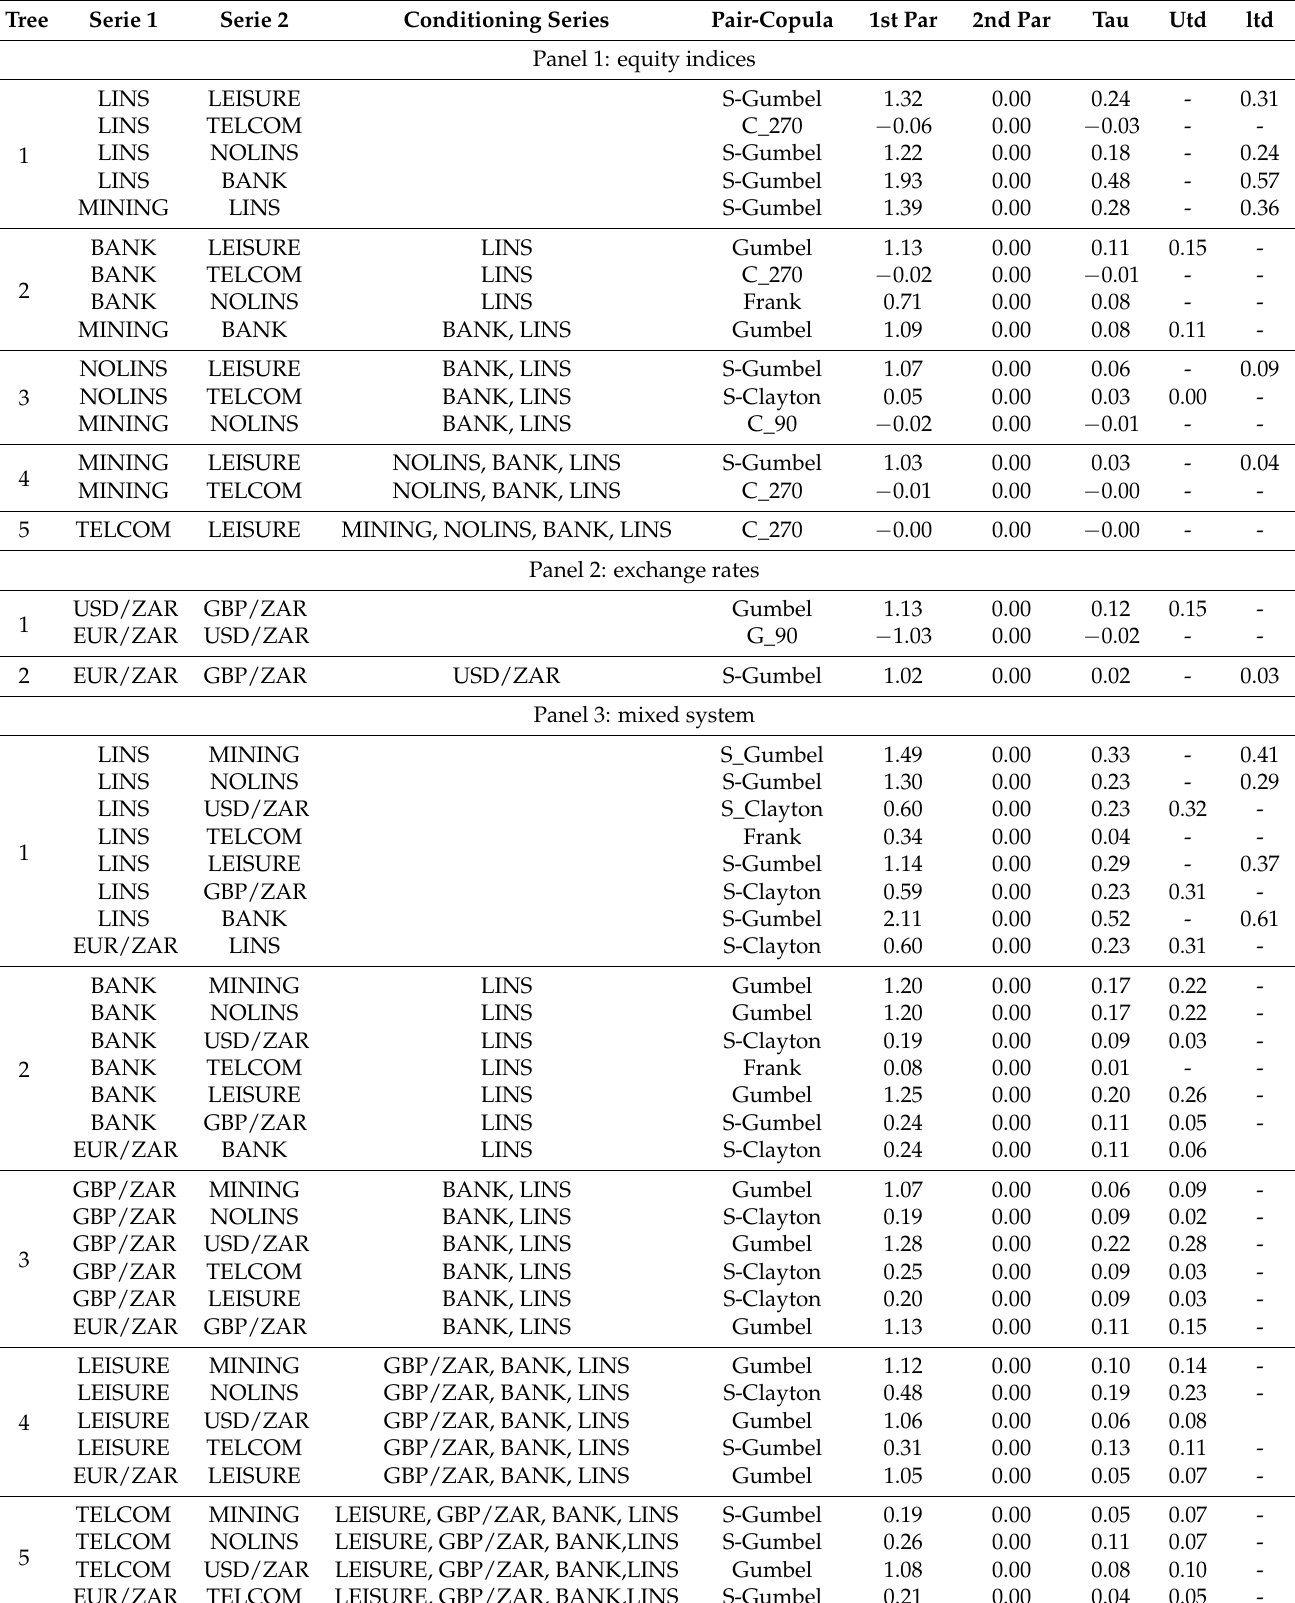
Table A2. Parameter estimates of the dependence structures using C-vine